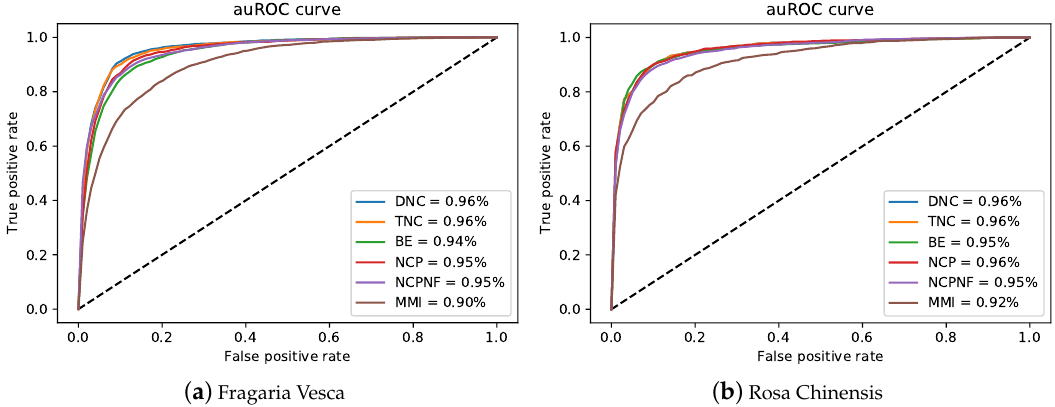
Figure 5. auRoc curves of six encoding methods for the proposed model on two training benchmark dataset.